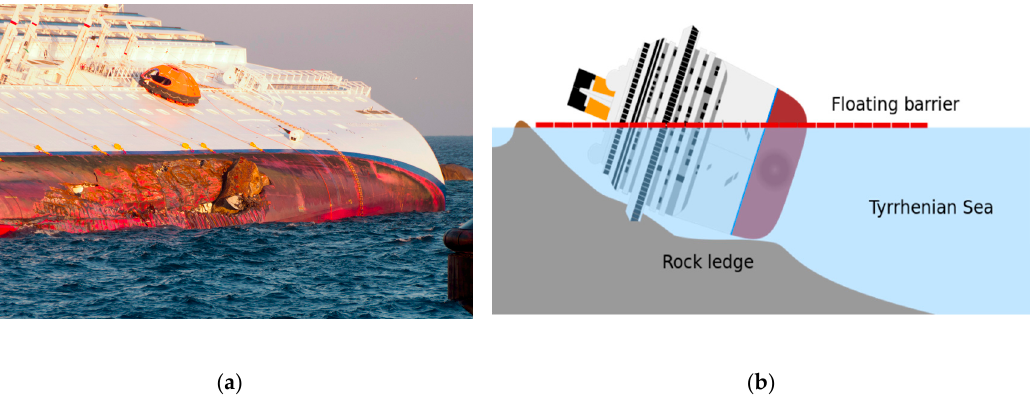
Figure 5. The Costa Concordia run aground close to the Giglio Porto, Italy after the collision with a reef on 12th of January 2012 ( a ) [18]. The shipwreck leaning with the starboard side against the seafloor with a final inclination of about 70 degrees ( b ) [19].